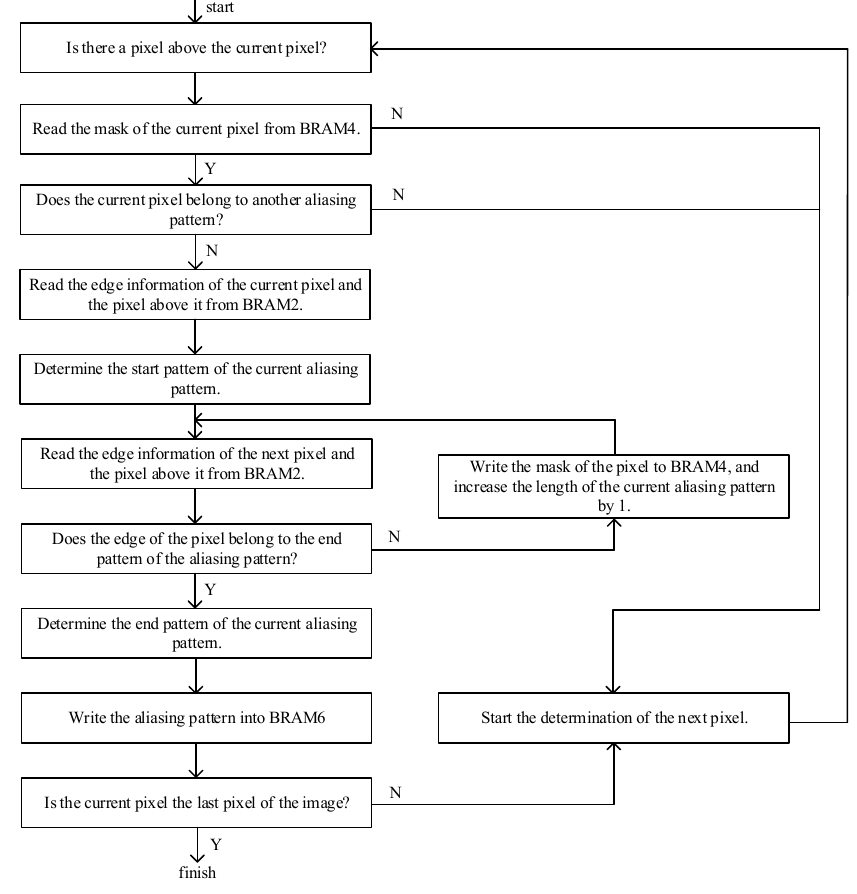
Figure 10. Flow diagram of the module Generate_Aliasing_Pattern (Horizon).